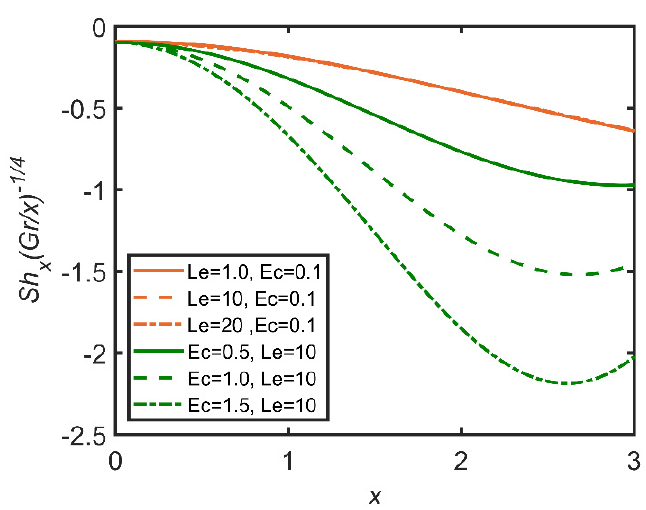
Figure 26. Comparison for Sherwood number against x.